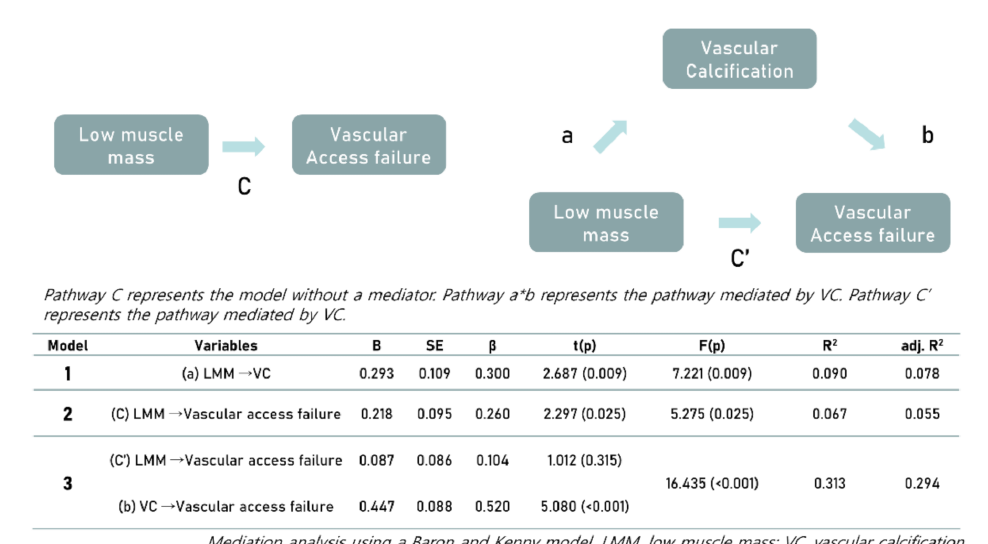
Figure 2. VC as a mediator of the association between LMM and recurrent vascular access failure. Mediation analysis of the association between VC and recurrent vascular access failure in which VC was considered as a mediator. Pathway C represents the model without a mediator. Pathway a*b represents the pathway mediated by VC. Pathway C’ represents the pathway not mediated by VC. Consequently, LMM is associated with vascular access failure, which mediates VC. Mediation analysis using the Baron and Kenny model. LMM, low muscle mass; VC, vascular